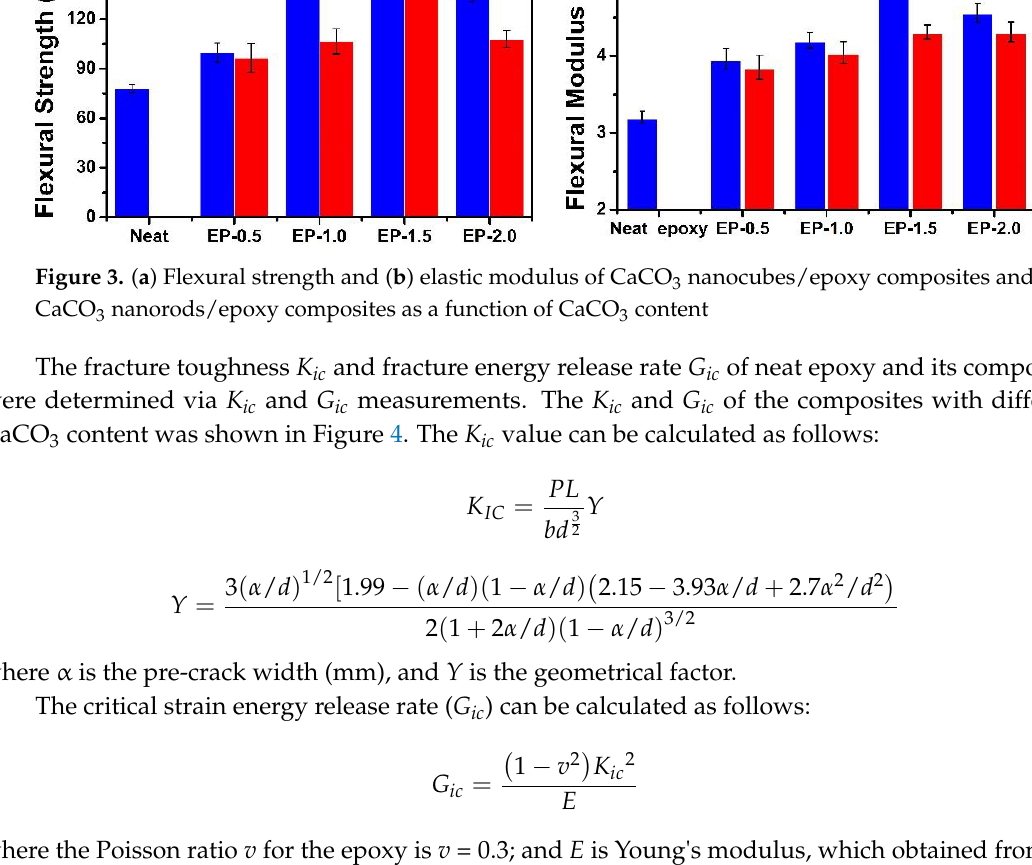
Figure 4. Fracture toughness ( K ic ) and fracture energy ( G ic ) of neat epoxy and its epoxy composites with different content of CaCO 3 .